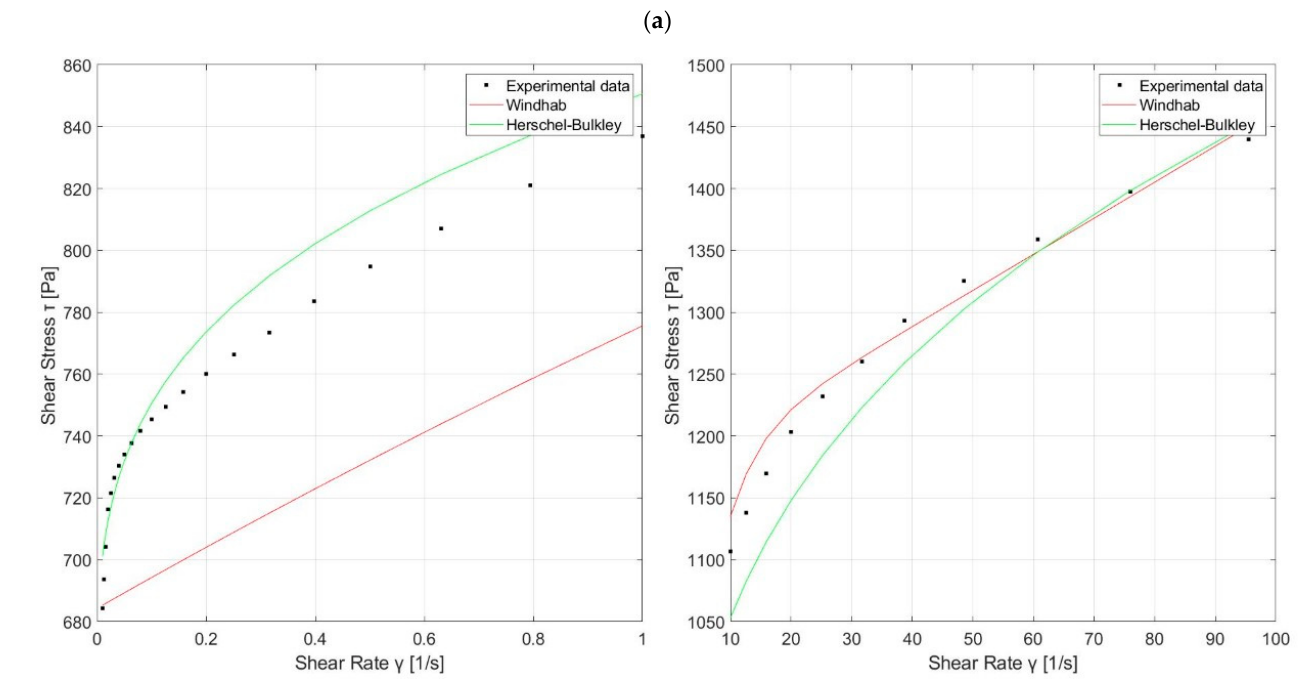
Figure 6. Experimental flow curve for hydroxide sludge fitted to Herschel–Bulkley and Windhab models for ( a ) all shear rate, ( b ) lower shear rates ( 𝛾(cid:4662) < 1 s (cid:2879)(cid:2869) ) and ( c ) higher shear rates ( 𝛾(cid:4662) > 10 s (cid:2879)(cid:2869) ).